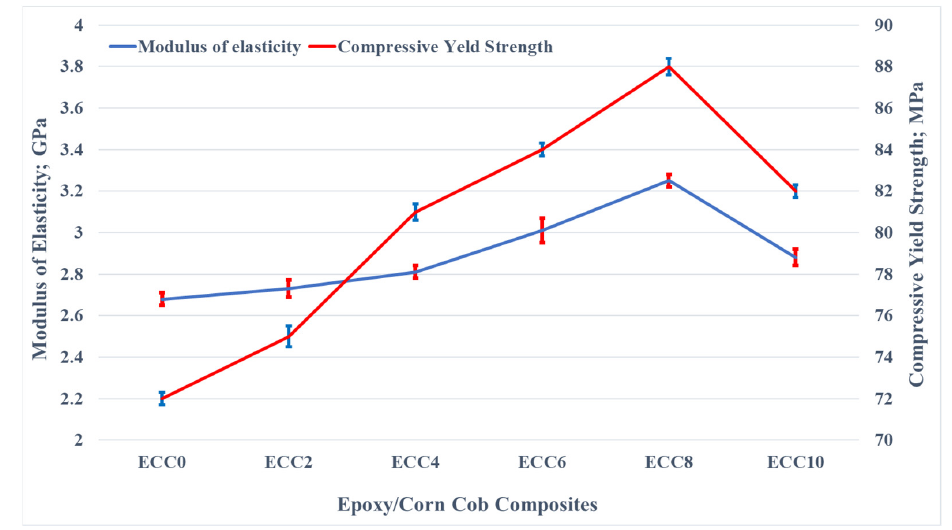
Figure 6. Young’s modulus and compressive yield strength of epoxy/corn cob